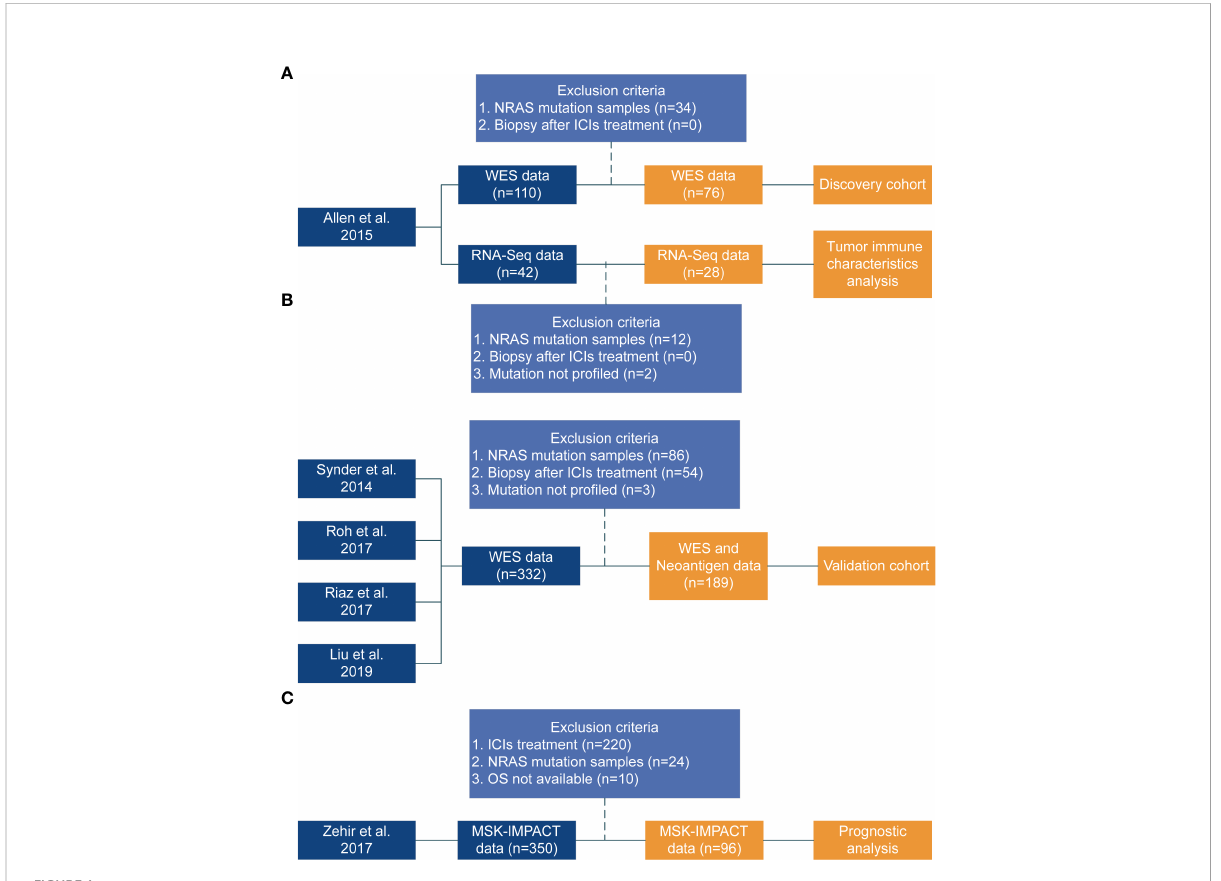
FIGURE 1 Flowchart of the study design. (A) Discovery cohort from published study [Allen et al. (22)]. (B) Coalition of the validation cohort from four published studies (Synder et al. (27), Roh et al. (28), Riaz et al. (26), Liu et al. (11)). The Synder, Roh, and Riaz study did not include PFS data. (C) Zehir study (29) data used to perform prognostic